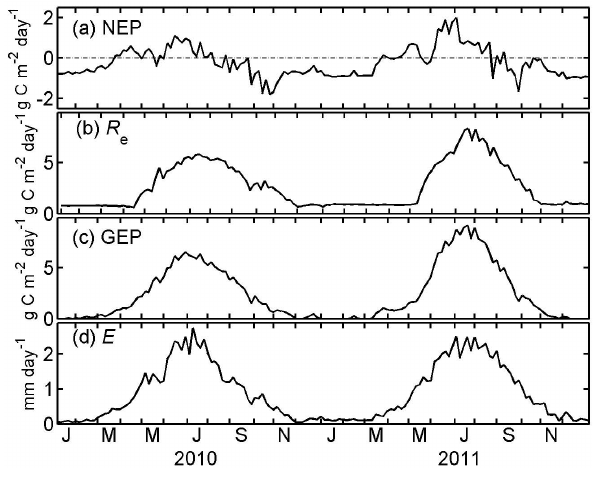
Fig. 5. 5-day averaged (a) net ecosystem production (NEP), (b) ecosystem respiration ( R e ) (c) gross ecosystem photosynthesis (GEP) and (d) evapotranspiration ( E) in 2010 and 2011.